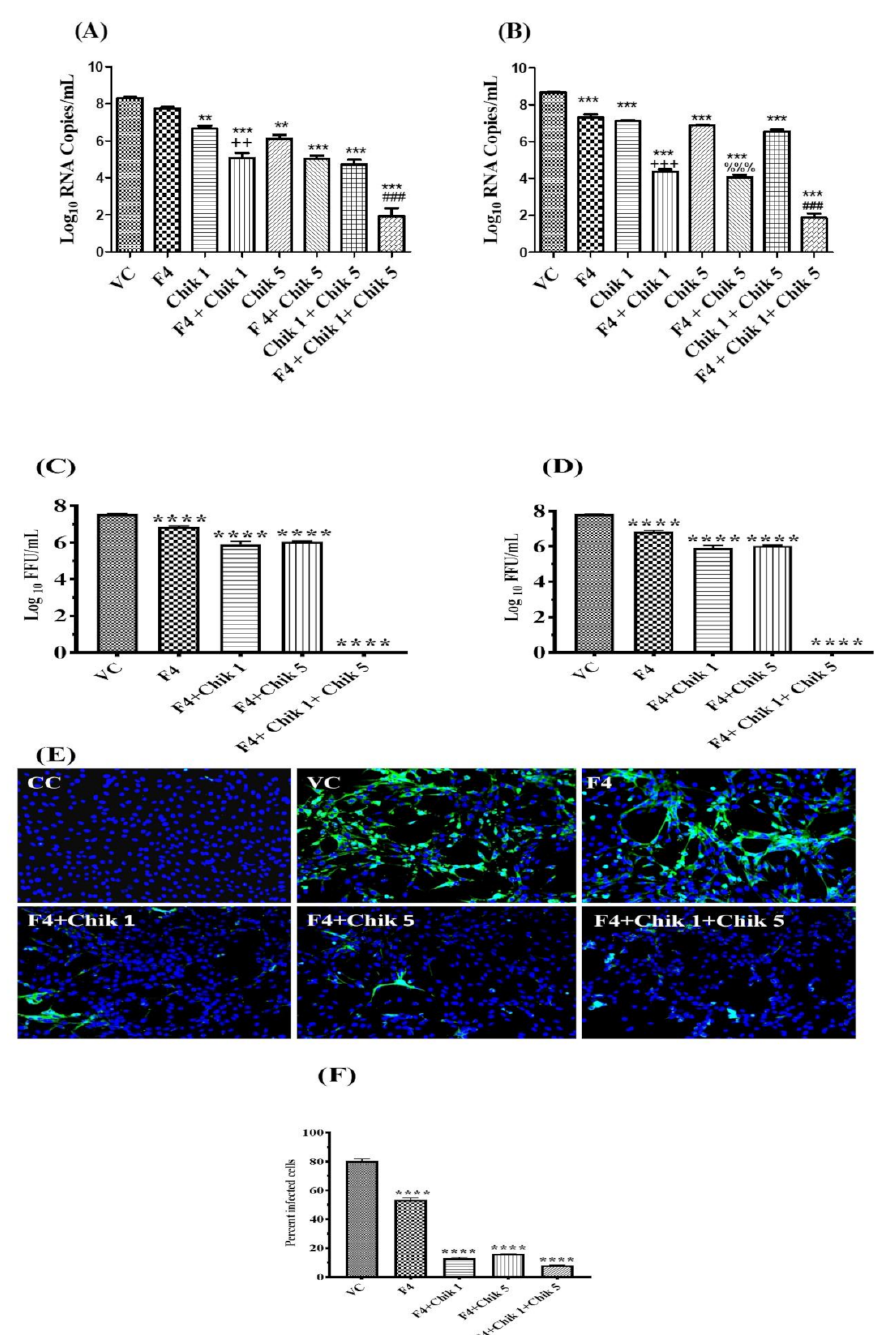
Figure 6. Effect of siRNA treatment against CHIKV replication. Naked siRNA (transfected with lipofectamine) and siRNA conjugated with F4 SLN effect at 24 h ( A ) and 48 h ( B ) using qRT-PCR analysis; siRNA conjugated with F4 SLN formulation using focus forming units (FFU) assay at 24 h ( C ) and 48 h ( D ); immunofluorescence assay (24 h treatment); ( E ) and percentage of infected cells ( F ).All values are given as mean log10 RNA copies/well ± SEM; **** p < 0.0001,*** p < 0.001, ** p < 0.01 vs. VC, virus control. ++ p < 0.01, +++ p < 0.001 vs. Chik 1, %%% p < 0.001 vs. Chik 5, ### p < 0.001 vs. Chik 1 + Chik 5. All the siRNA combination conjugated with F4 SLN showed significant ( p < 0.001) reduction to their respective treatment of naked siRNA with lipofectamine at 48 h; it indicated the superiority of the F4 SLN delivery system over transfection with